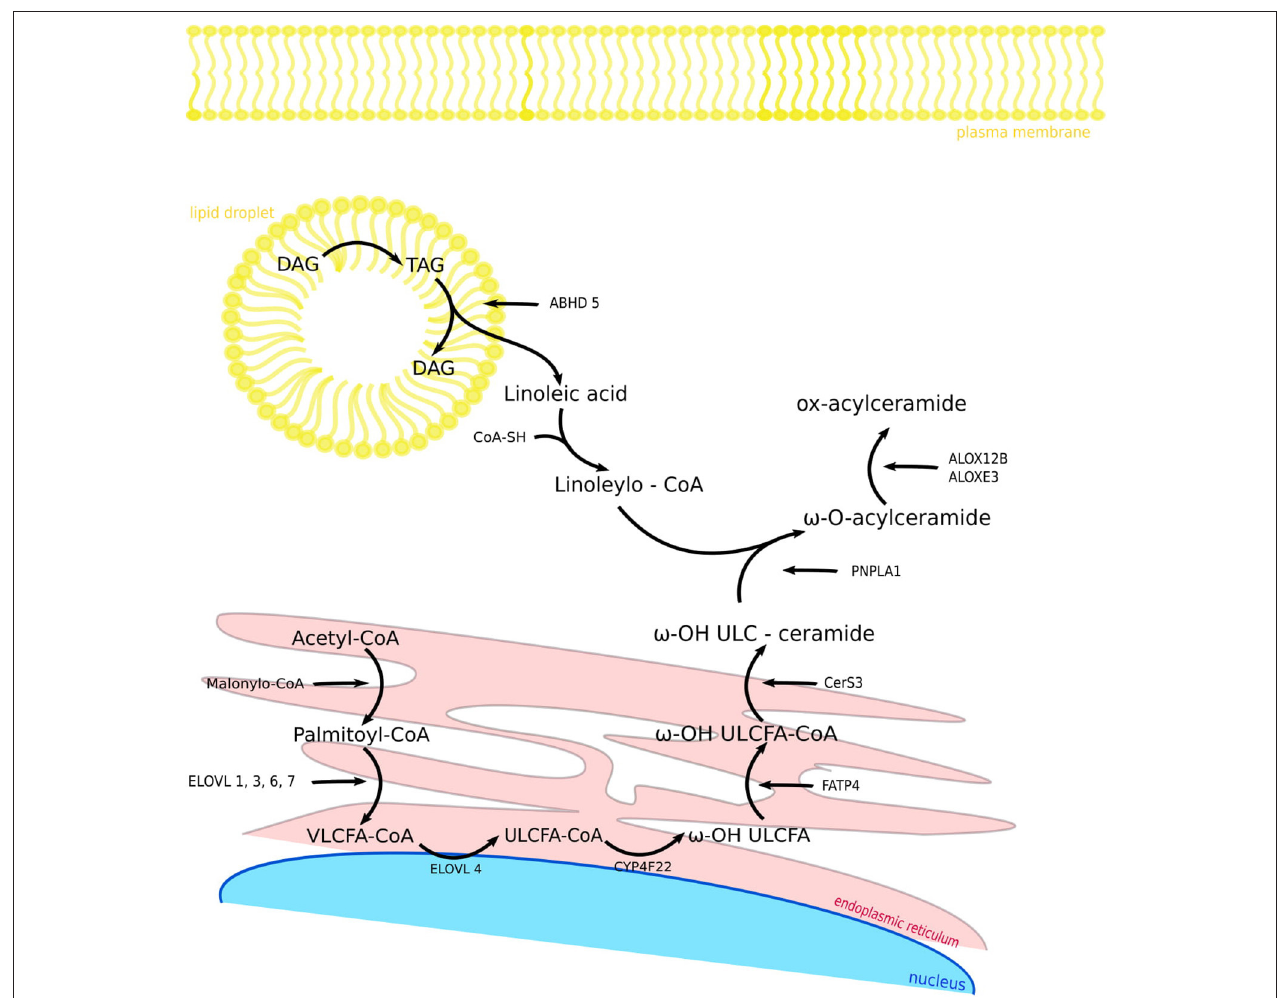
FIGURE 2 | Components and biosynthetic steps of fatty acid modification in the skin. FASN1 catalyzes de novo synthesis of fatty acids from acetyl-CoA and malonyl-CoA. After activation to acyl-CoA esters, the acyl chain is elongated to VLCFA-CoA esters. CYP4F22 catalyzes ω -hydroxylation ULCFA-CoA to ω -OH ULCFA and FATP4 synthesize ω -OH ULCFA-CoA. CerS3 enables the synthesis of ω -OH ULC-ceramide. In the same time in lipid droplet TAG is hydrolyzed by ATGL activated by the ABHD5 to linoleic acid, which is synthesize with CoA-SH by receiving Linoleoyl-CoA. PNPLA1 catalyzes as a transacylase the formation of an ester bond between ω -hydroxyceramide and linoleoyl-CoA, so that we get ω -O-acylceramide. ALOX12B and ALOXE3 are responsible for oxidizing linoleic acid when it is attached to acylceramide. FASN1, fatty acid synthase 1; VLCFA-CoA, very long-chain fatty acid CoA; ELOVL, fatty acid elongase; ULCFA-CoA, ultra long-chain fatty acid CoA; CYP4F22, Cytochrome P450 Family 4 Subfamily F Member 22; FATP4, fatty acid transporter 4; CerS3, ceramide synthase 3; ABHD5, abhydrolase domain containing 5; PNPLA1, patatin like phospholipase domain containing 1; ALOX12B, arachidonate 12-lipoxygenase, 12R type; ALOXE3, arachidonate lipoxygenase 3; TAG, triacylglycerol; DAG,